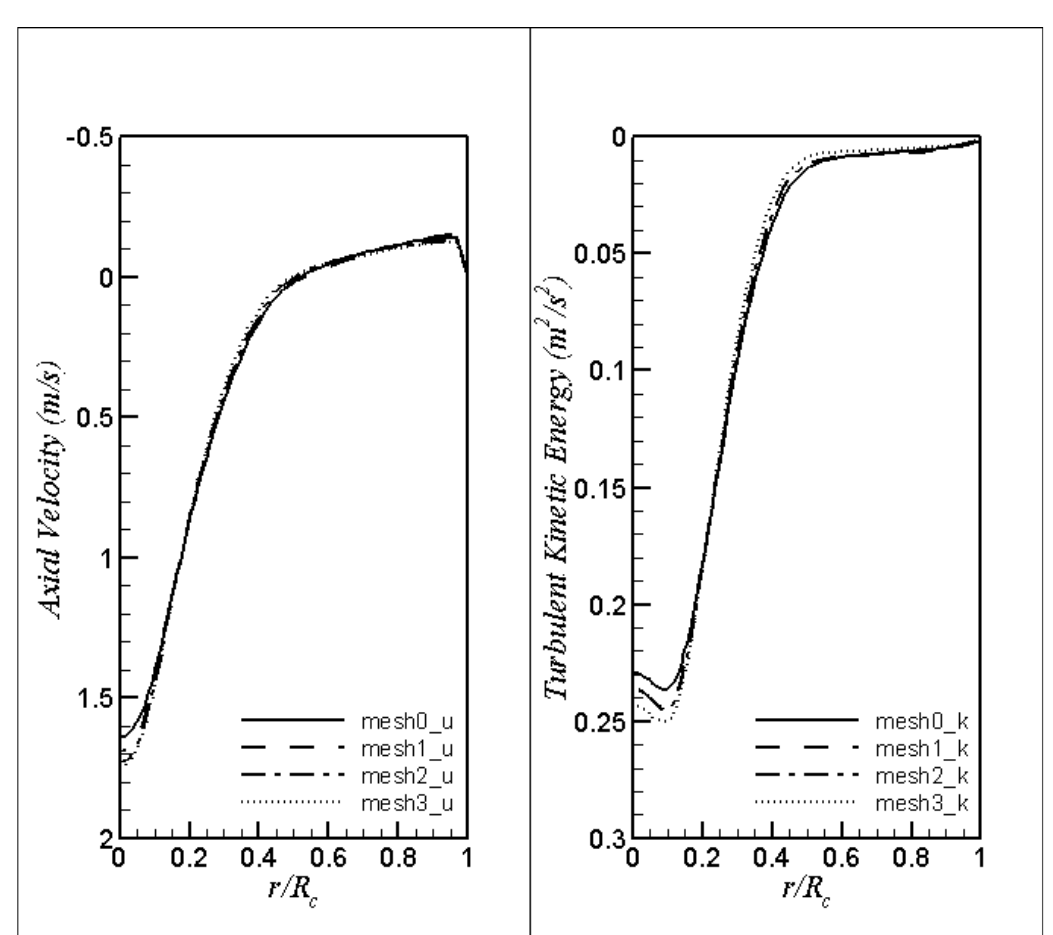
Figure 6: Radial variation turbulent kinetic energy (left) and turbulent intensity (right) at 100 mm below the nozzle V =12 for three different meshes [ q